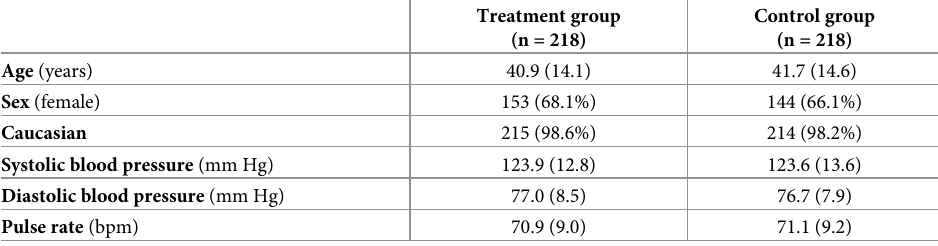
Table 1. Baseline characteristics (Visit 1) of the full analysis set (FAS)